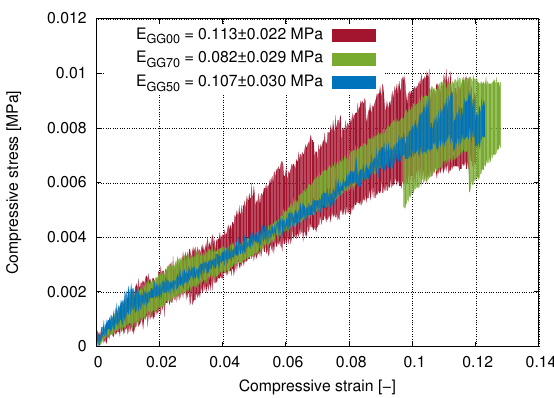
Figure 1. Stress–strain curves envelope of scaffolds under compressive loading